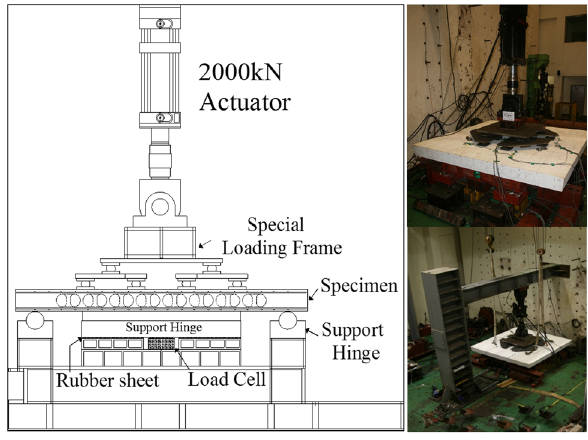
Fig. 5 Test set-up